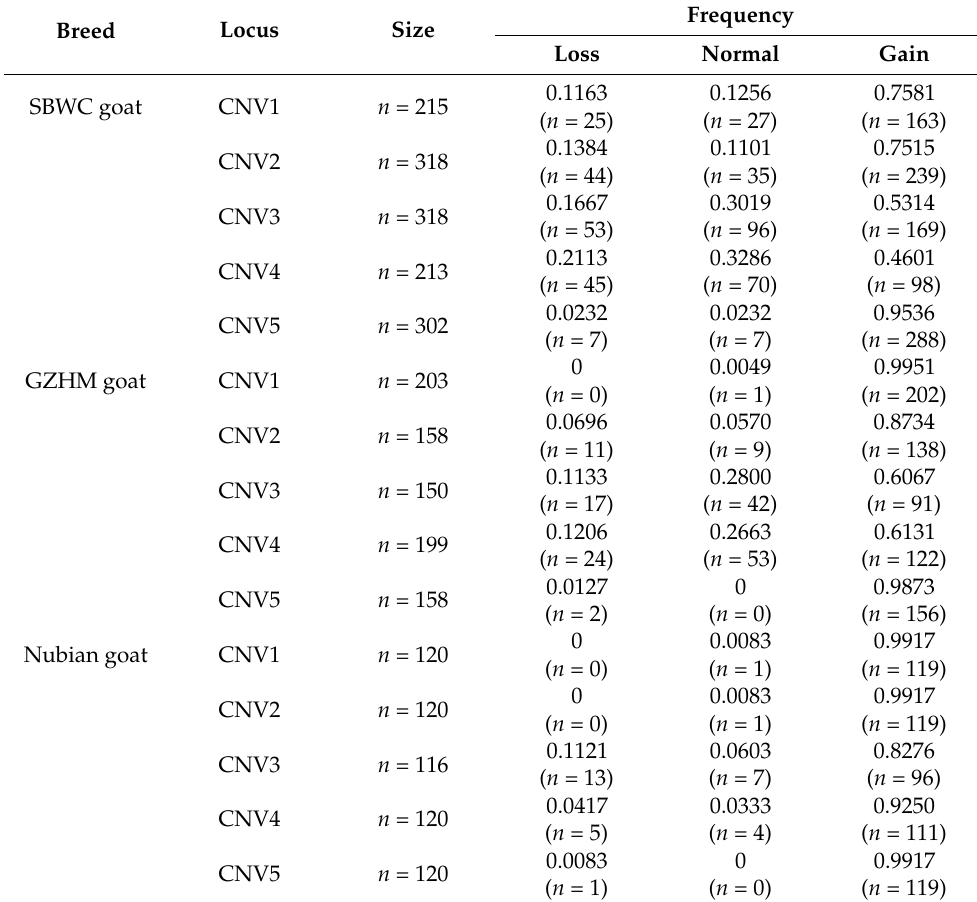
Frequency Loss Normal Gain 0.1163